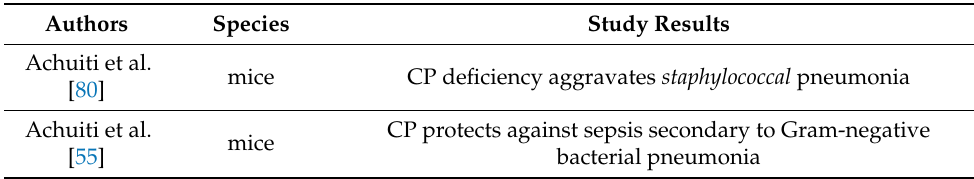
Table 3. CP in infectious diseases, animal